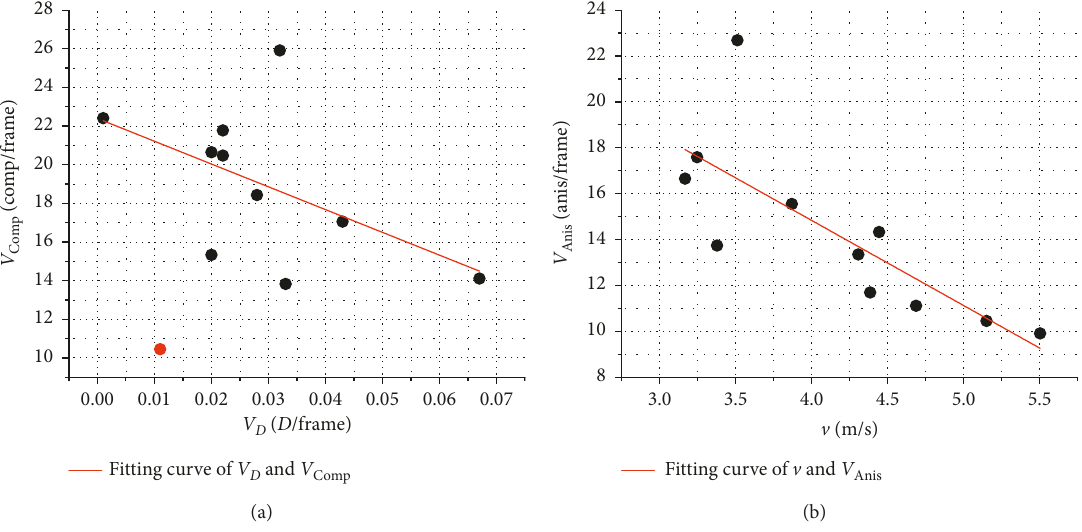
Figure 12: (a) Relationship between V